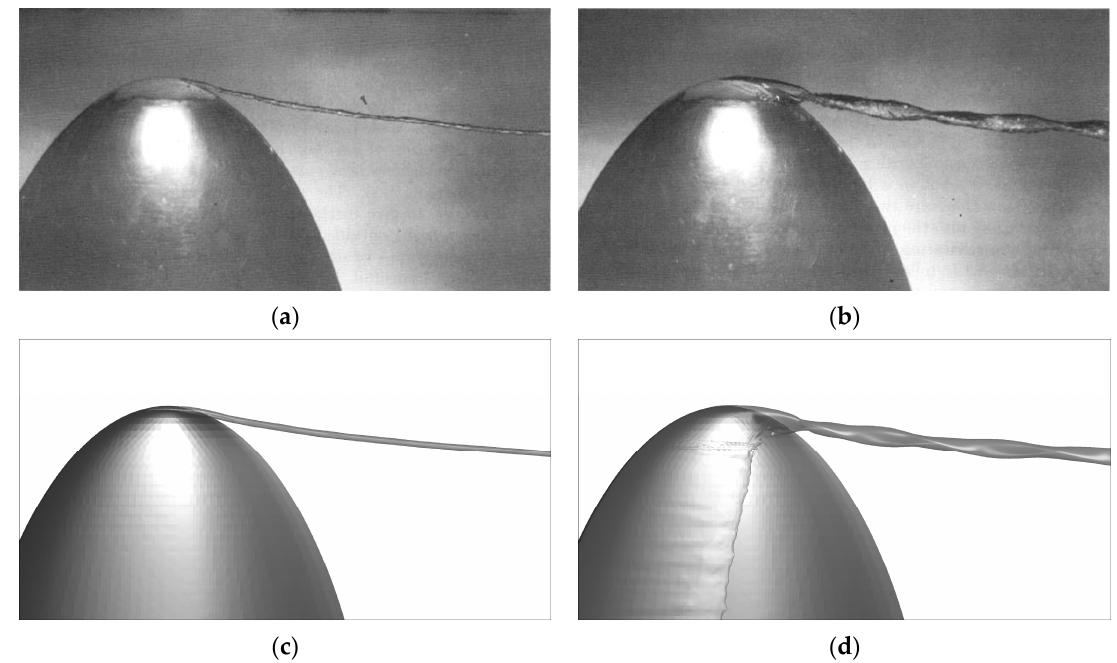
Figure 12. Development of tip vortex cavitation at different cavitation numbers: ( a ) EXP, 𝜎 = 1.15; ( b ) EXP, 𝜎 = 0.58; ( c ) CFD, 𝜎 = 1.15; ( d ) CFD, 𝜎 = 0.58.